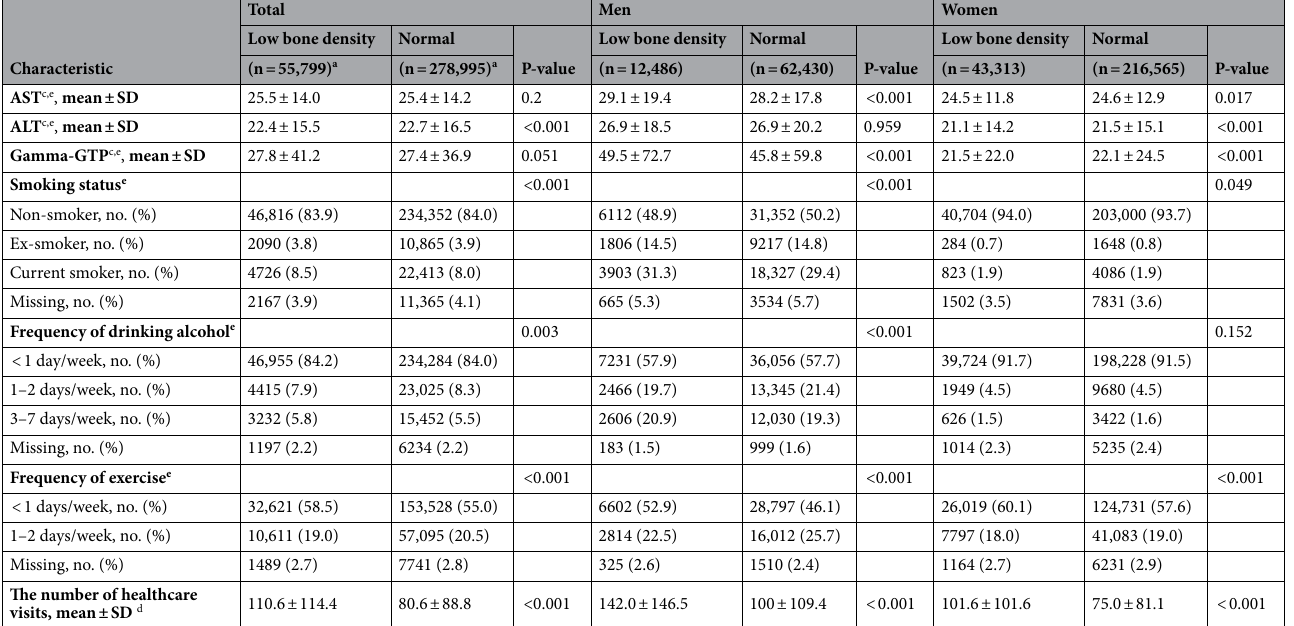
Table 1. Baseline characteristics of the study population. a Not all 334,794 subjects (total patients: 55,799, total control: 278,995) had information for all listed measures. Specifically, body mass index (BMI) was available for 334,667 subjects; blood pressure was available for 334,674 subjects; fasting blood glucose was available for 334,483 subjects; total cholesterol was available for 334,357 subjects; hemoglobin was available for 334,450 subjects; urine occult blood was available for 333,192 subjects; urine protein was available for 333,201 subjects; AST was available for 334,411 subjects; ALT was available for 334,416 subjects; gamma-GTP was available for 334,489 subjects; smoking status was available for 321,262 subjects; frequency of drinking alcohol was available for 327,363 subjects; and frequency of exercise was available for 325,564 subjects. b Aromatase inhibitors and aromatase deprivation therapy were available only for women and men, respectively. c DMPA depot-medroxyprogesterone acetate, TCA tricyclic antidepressant, BMI body mass index, SBP systolic blood pressure, DBP diastolic blood pressure, AST aspartate transaminase, ALT alanine transaminase, GTP glutamyltransferase, CCI Charlson comorbidity index. d The prescriptions of the medications and the number of healthcare visits were measured during the observation period. e Bio-clinical laboratory results, demographic information and history of smoking and drinking alcohol were measured at the baseline. f The Charlson comorbidity index (CCI) was calculated based on claims collected for two years before the baseline exam.